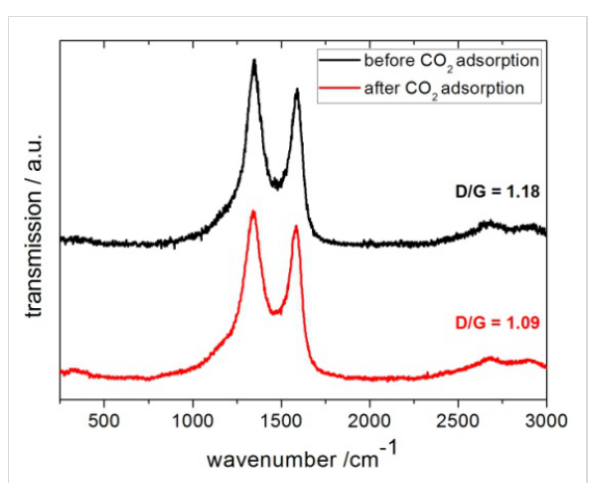
Figure 11: Raman spectra of carbon tubes ( 4 ) before (black/top) and after (red/bottom) high pressure CO 2